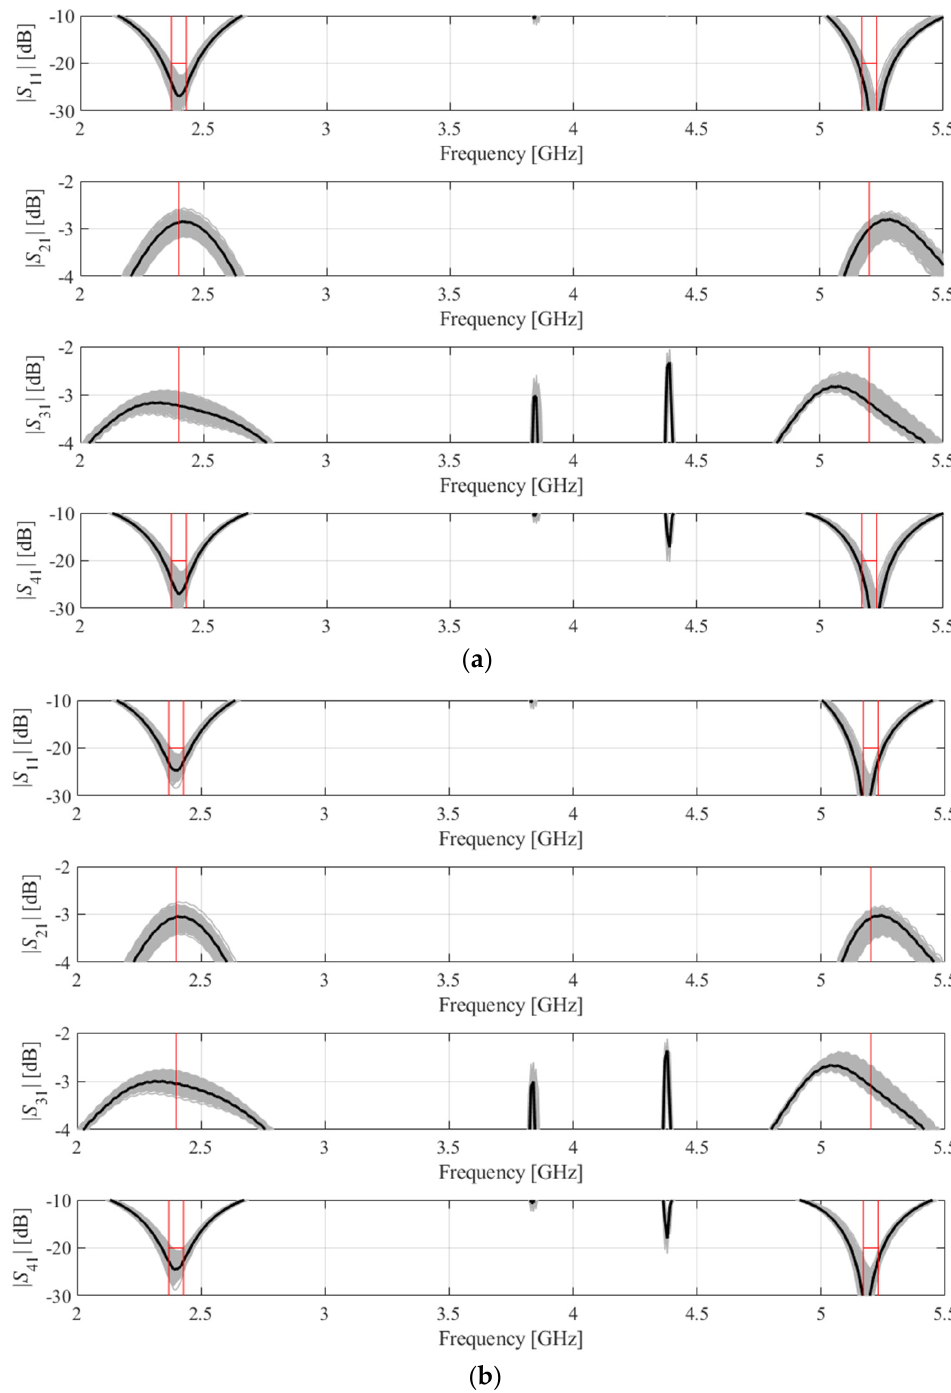
Figure 7. EM-driven Monte Carlo simulation of Circuit III (Figure 3c) at ( a ) the nominal design, and ( b ) the final design obtained using the proposed algorithm. MC carried out using 500 random samples. EM simulation data shown as gray curves. Black plots show the circuit responses at the nominal ( a ) and the optimized design ( b ).